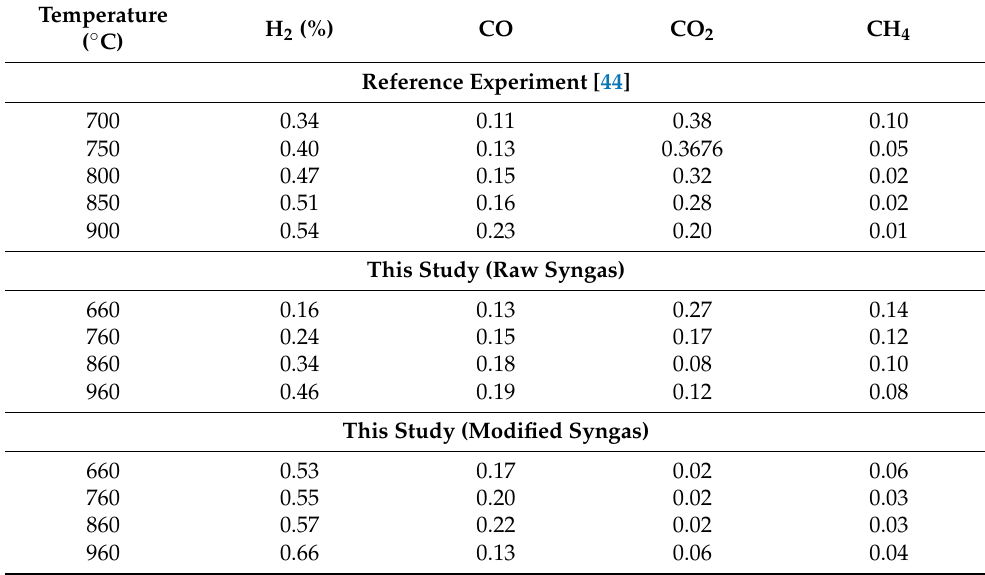
Table 4. Validation for the effect of gasification